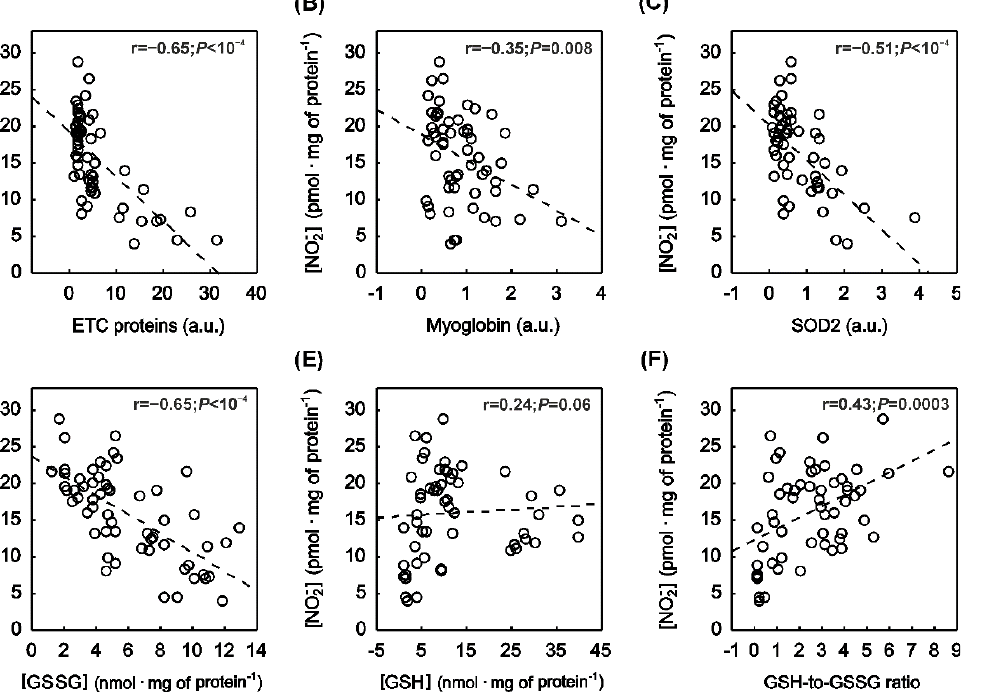
Figure 4. The relationship between muscle nitrite concentration and proteins engaged in oxygen metabolism and redox balance. The relationship between muscle nitrite ([NO 2 − ]) and the sum of electron transport chain proteins (ETC, ( A )), [NO 2 − ] and myoglobin content ( B ), [NO 2 − ] and superoxide dismutase type 2 content (SOD2, ( C )), [NO 2 − ] and oxidised glutathione concentration ([GSSG], ( D )), [NO 2 − ] and reduced glutathione concentration ([GSH], ( E )), and [NO 2 − ] and antioxidant capacity of the tissue ([GSH ‐ to ‐ GSSG], ( F )). Dashed lines represent least ‐ squares linear fits based on 60 muscle samples taken from the heart ( n = 12), Sol ( n = 12), MGS ( n = 12), TA ( n = 12) and MGF ( n = 12).